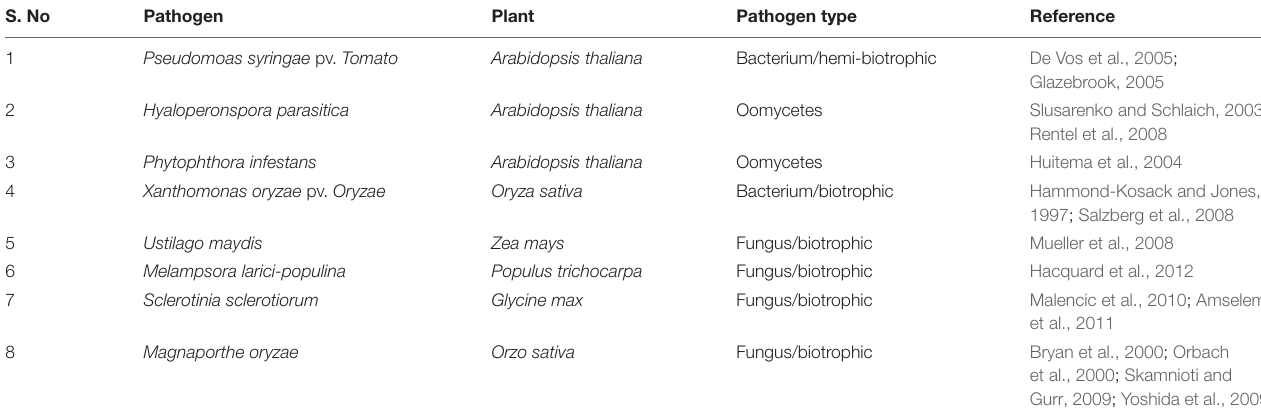
TABLE 1 | Overview of selected plant − microbe pairs extensively studied and represented as most suitable pathosystem. S.